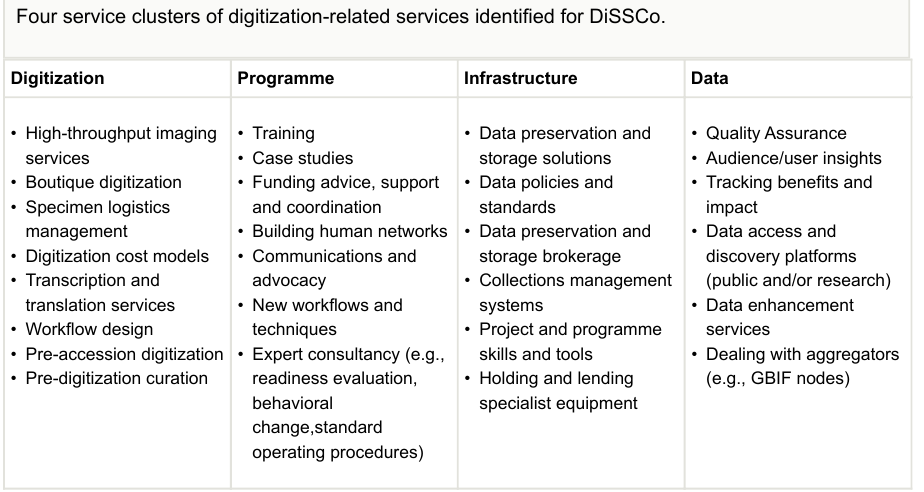
Conceptual design blueprint for the DiSSCo digitization infrastructure